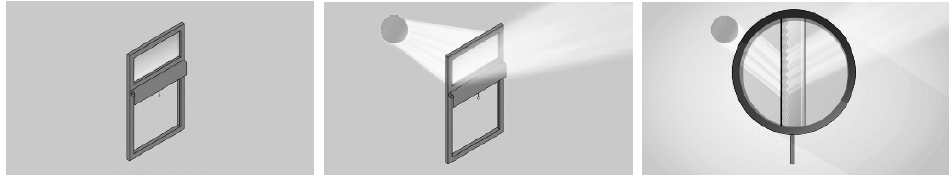
Figure 10 . The description of how 3M™ Daylight Redirecting Film works [19].